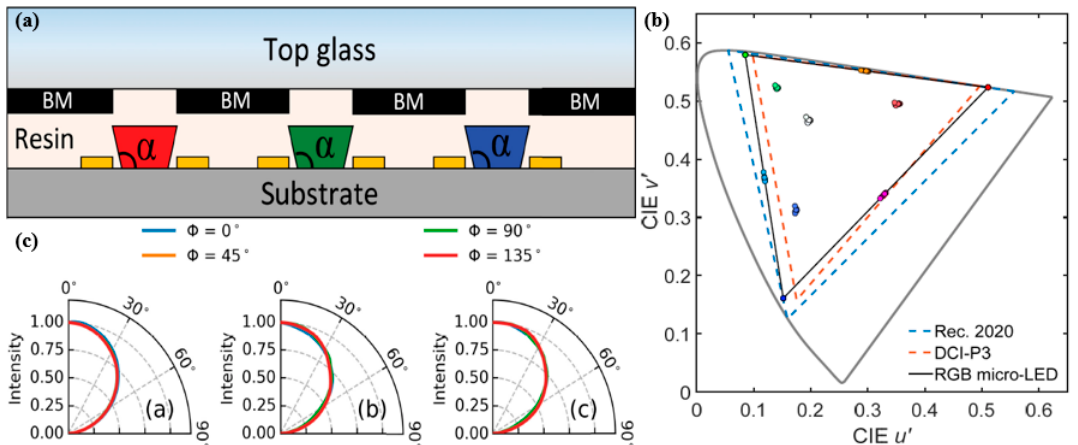
Figure 7. ( a ) RGB µ LED display with top black matrix. ( b ) Simulated color shifts of ten reference colors at viewing angles from 0 ◦ to 80 ◦ for the RGB µ LED display with a top black matrix and 120 ◦ taper angle. ( c ) Simulated radiation patterns for RGB µ LEDs with top black matrix [53]. Figure reproduced with permission from Optical Society of America.